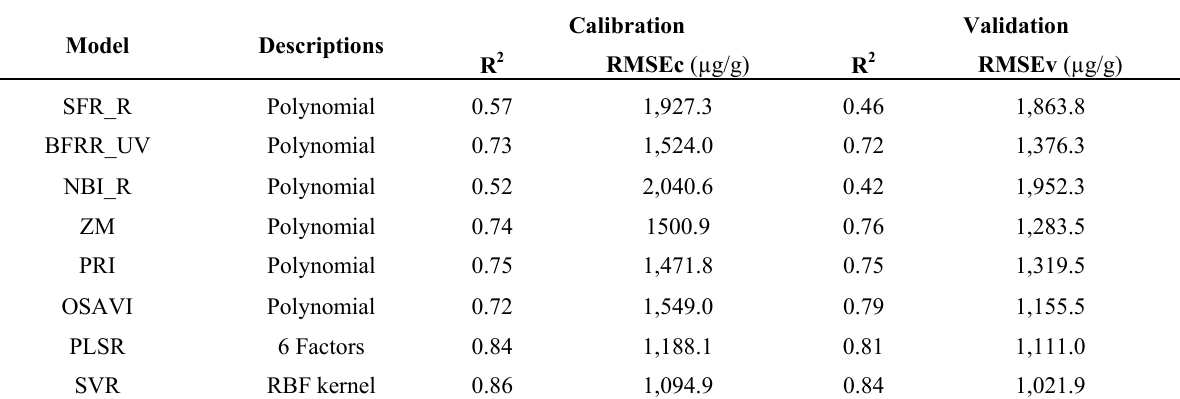
Table 6. Results of LCC estimations in calibration and validation data sets using SFR_R, vector regression (SVR) (RMSEc and RMSEv represent root mean square errors for calibration and validation, respectively).